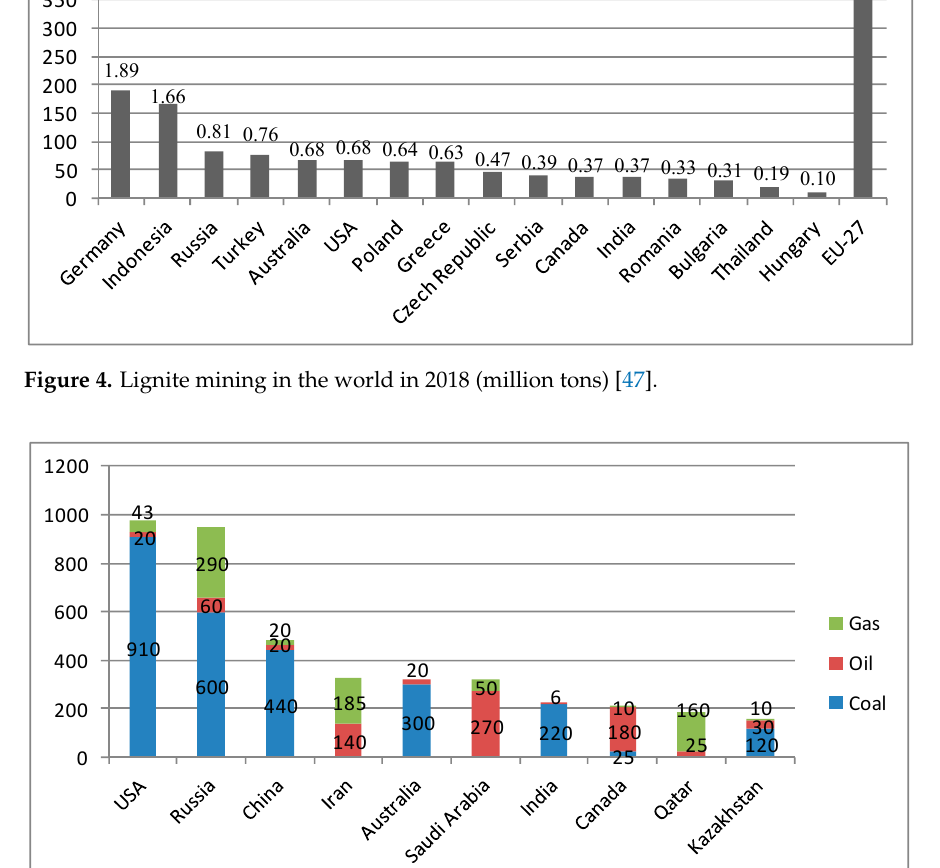
Figure 5. The ten richest countries in the world in energy resources (billion toe) [48,49]. Global data leave no doubt that, according to the forecasts in the 21st century, coal will again become the first energy resource in the world. This tendency is confirmed by the world’s carbon resources, which are globally evenly distributed and constitute 60% of the basket of the three main energy sources of the modern world (Figure 6).